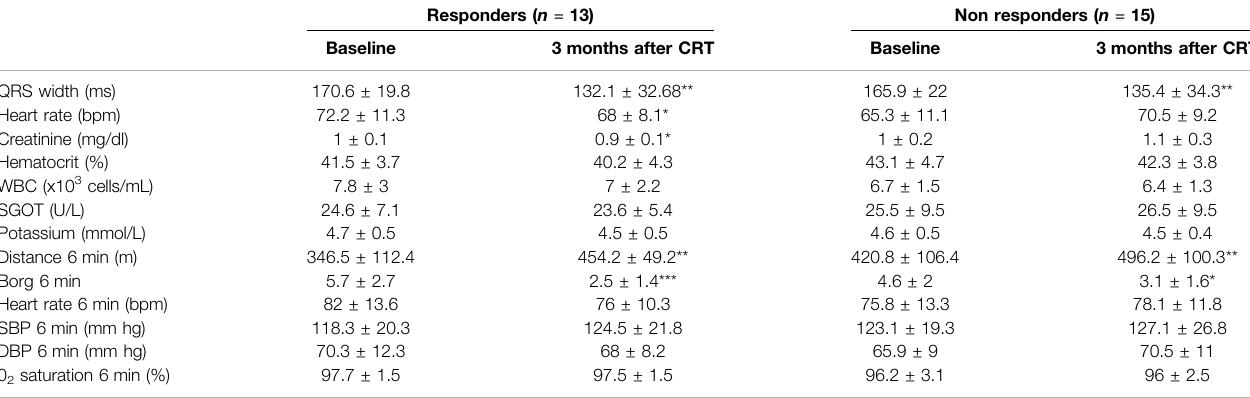
TABLE 2 | Blood pressure, heart rate, blood chemistry and exercise capacity 3 months after cardiac resynchronization therapy. Responders ( n = 13)